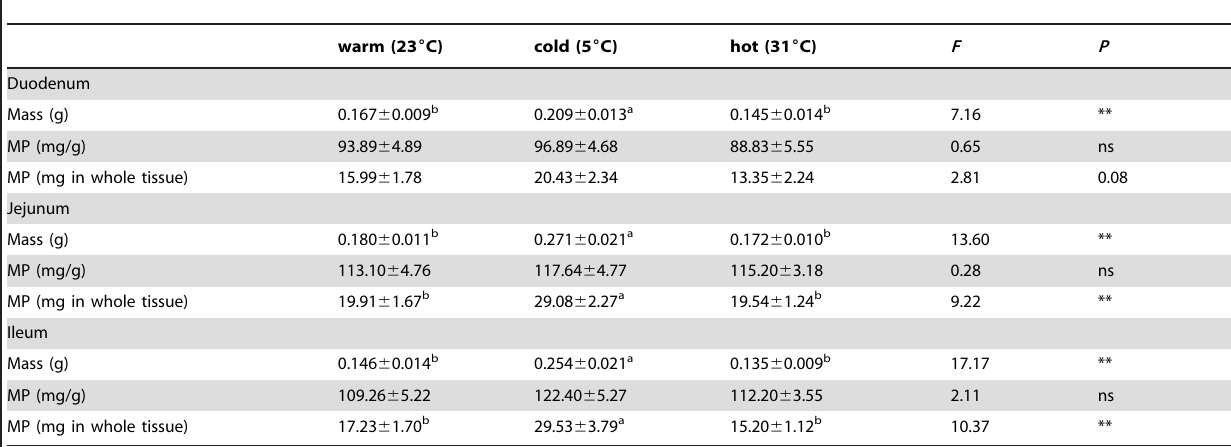
Table 2. Masses and mitochondria protein (MP) content of small intestine in striped hamsters exposed to warm, cold and hot